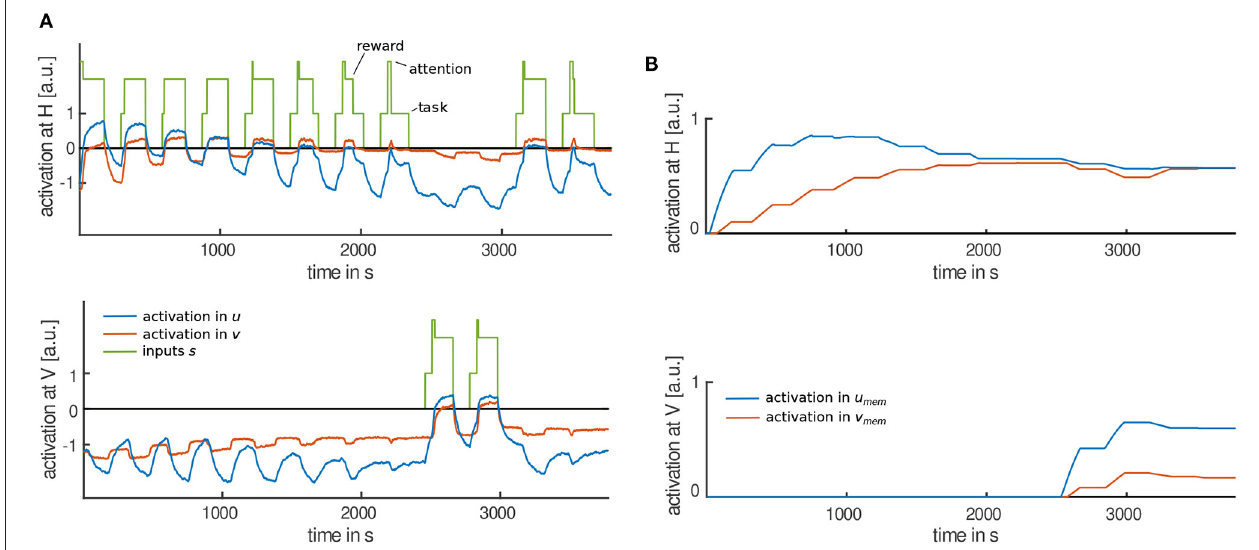
FIGURE 6 | (A) Exemplary time courses of the movement intention u (blue), the habituation field v (red) and stimulus inputs applied (green) at the horizontal (top) and vertical (bottom) field location. (B) Corresponding time courses of the memory trace, u mem , of the intention field (blue) and the memory trace, v mem , of the habituation field (red) at horizontal (top) and vertical (bottom) field